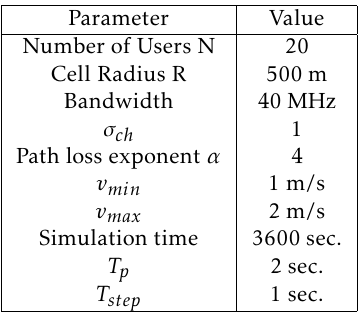
Table 1. Simulation Parameter